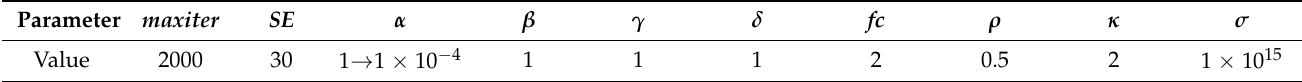
Table 10. Parameter settings of the two-stage STA.